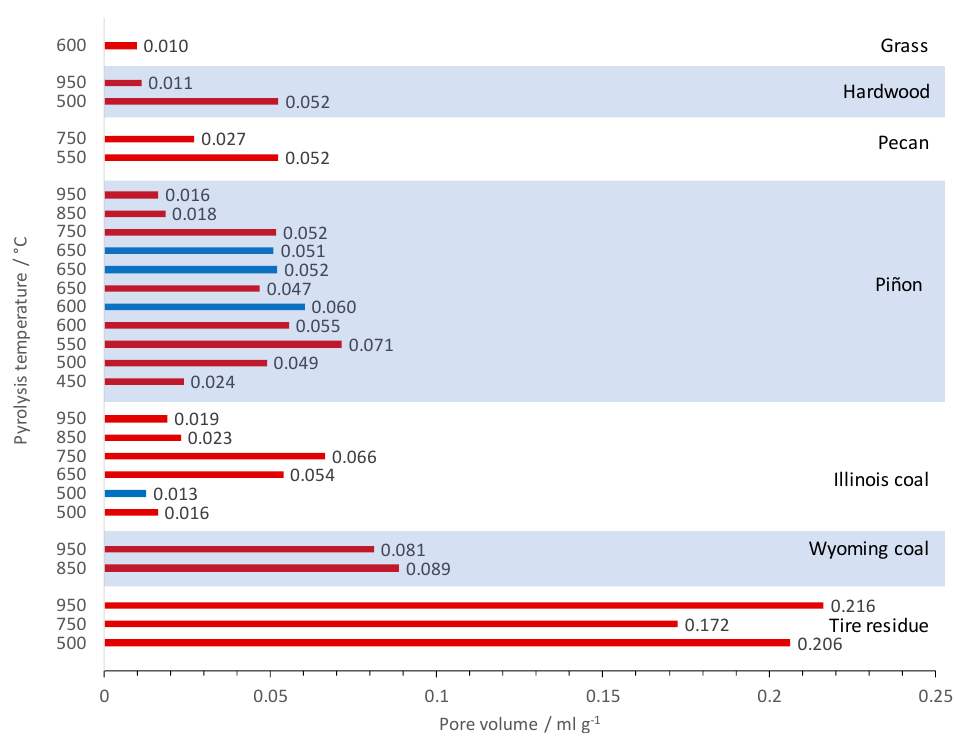
Figure 10. Summary of pore volume data for samples prepared in the tube furnace at the indicated pyrolysis temperatures under flowing nitrogen (red bars) or flowing 0.11% (vol.) oxygen in nitrogen (blue bars). All data are normalized to the mass of the feedstock before pyrolysis.